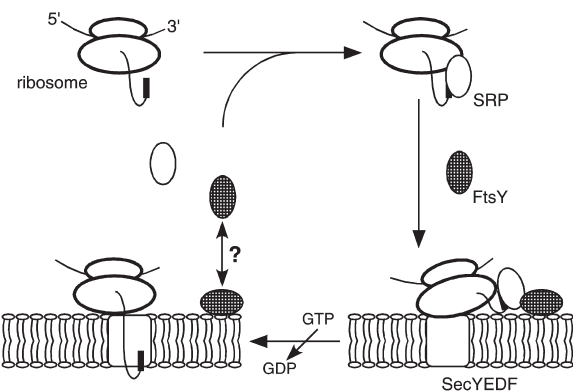
Figure 1. The hypothetical signal recognition particle (SRP) cycle of Archaea. Proteinsdestinedtocrossthearchaealplasmamembraneare synthesized with a cleavable N-terminal extension (the signal